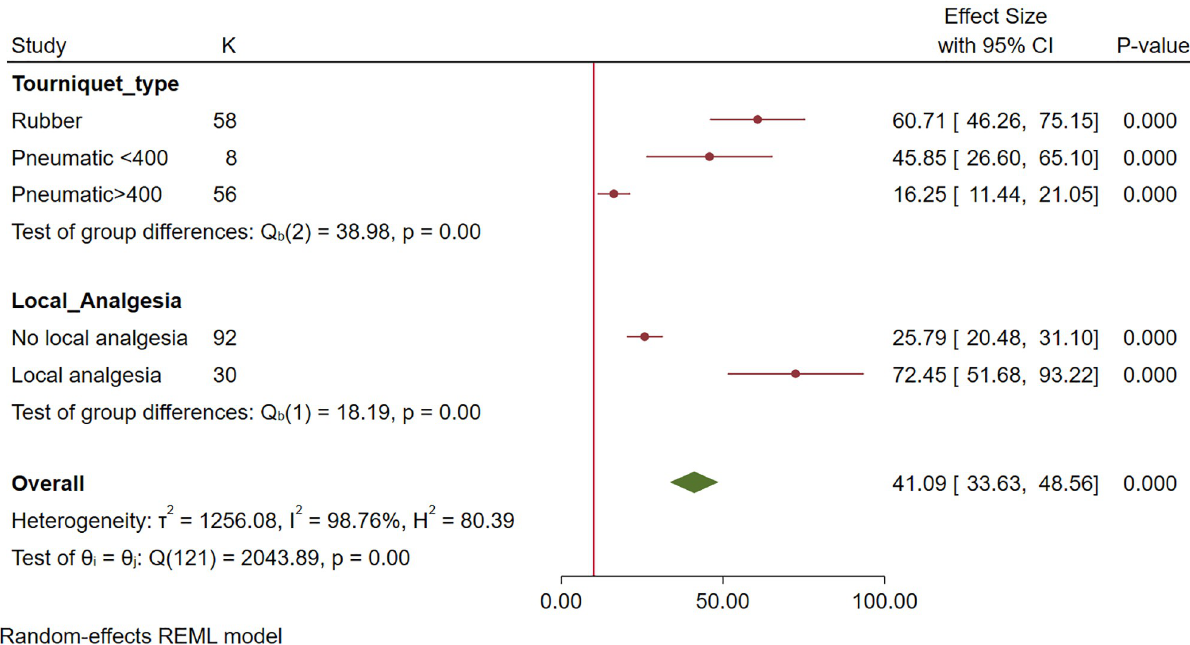
Fig 2. Forest plot by subgroups retained in the final multivariable meta-regression showing concentrations of antibiotics achieved in the synovial structure (multiples of the MIC) for susceptible bacteria. The vertical red line represents 10x MIC. Red circles represent point estimates, red horizontal lines represent 95% confidence intervals. The green diamond represents the summary measure θ , but this measure is not considered reliable due to the high heterogeneity between